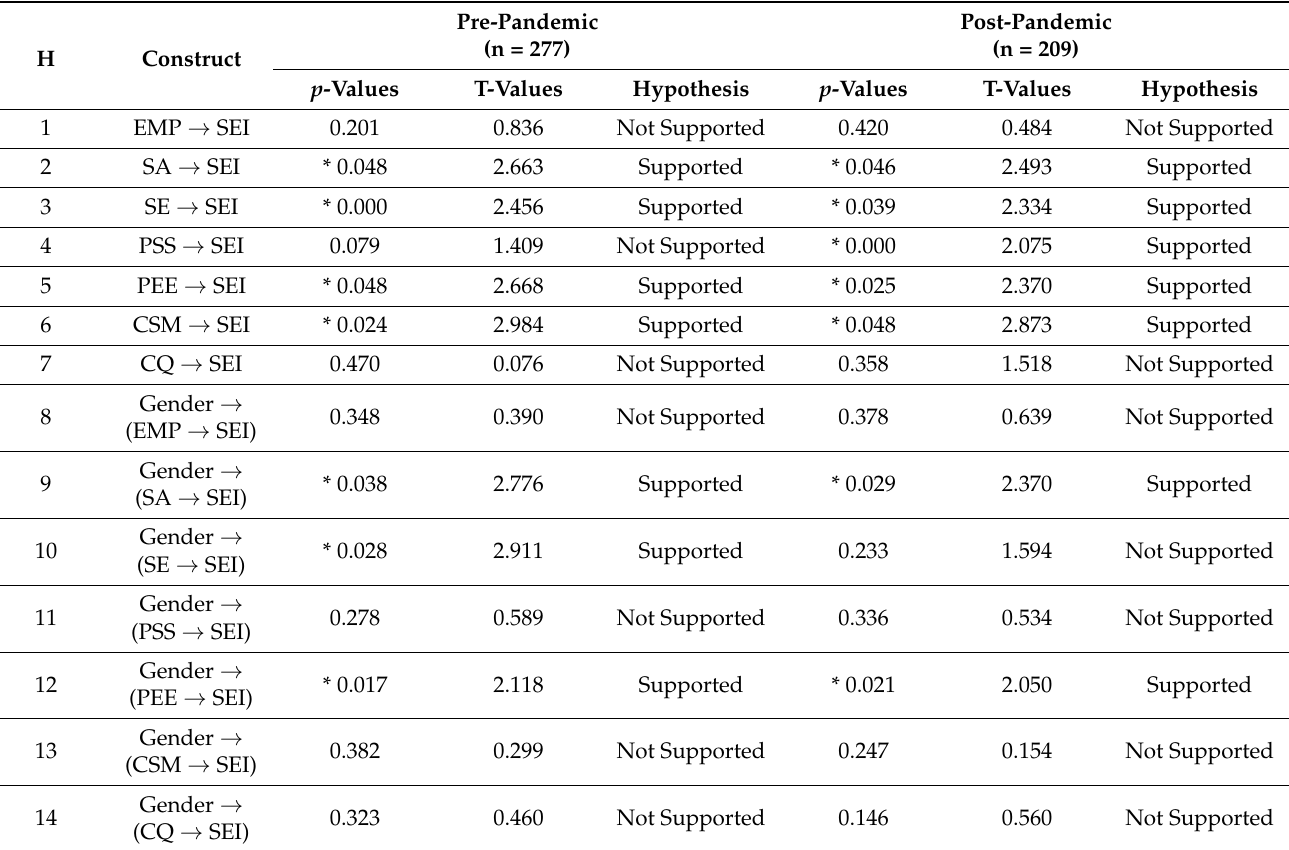
Table 8. Hypotheses